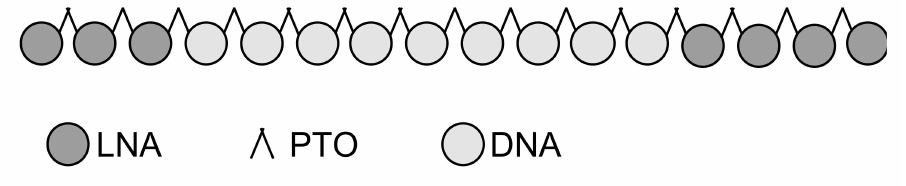
Figure 1. Chemical structure of the lead candidate 16mer antisense oligonucleotide. 5‘ and 3‘ wings consist of locked nucleic acids (LNA) to protect the ASO from degradation by exonucleases. LNA and deoxyribonucleic acid (DNA) are linked by a phosphorothioate backbone (PTO).